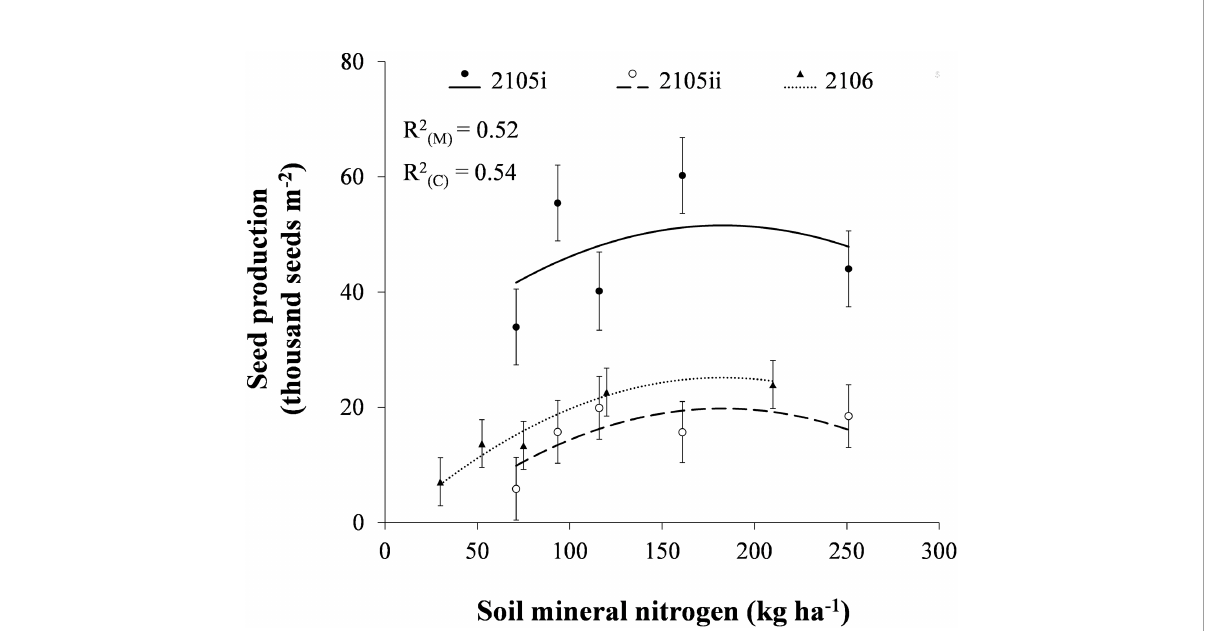
FIGURE 3 The number of volunteer canola seeds produced per unit area in response to soil mineral nitrogen in soybean in the 2015i, 2015ii, and 2016 environments. Dots indicate means of volunteer canola seed production for each level of soil mineral nitrogen in each environment in a combined analysis among volunteer canola populations. Error bars indicate ± SEM. All linear and quadratic components were signi fi cantly different from 0 ( a = 0.05). Marginal (R 2 (M) ) and conditional (R 2 (C) ) coef fi cients of determination are indicated for the entire linear mixed effects model. All model parameters are described in Supplementary Table